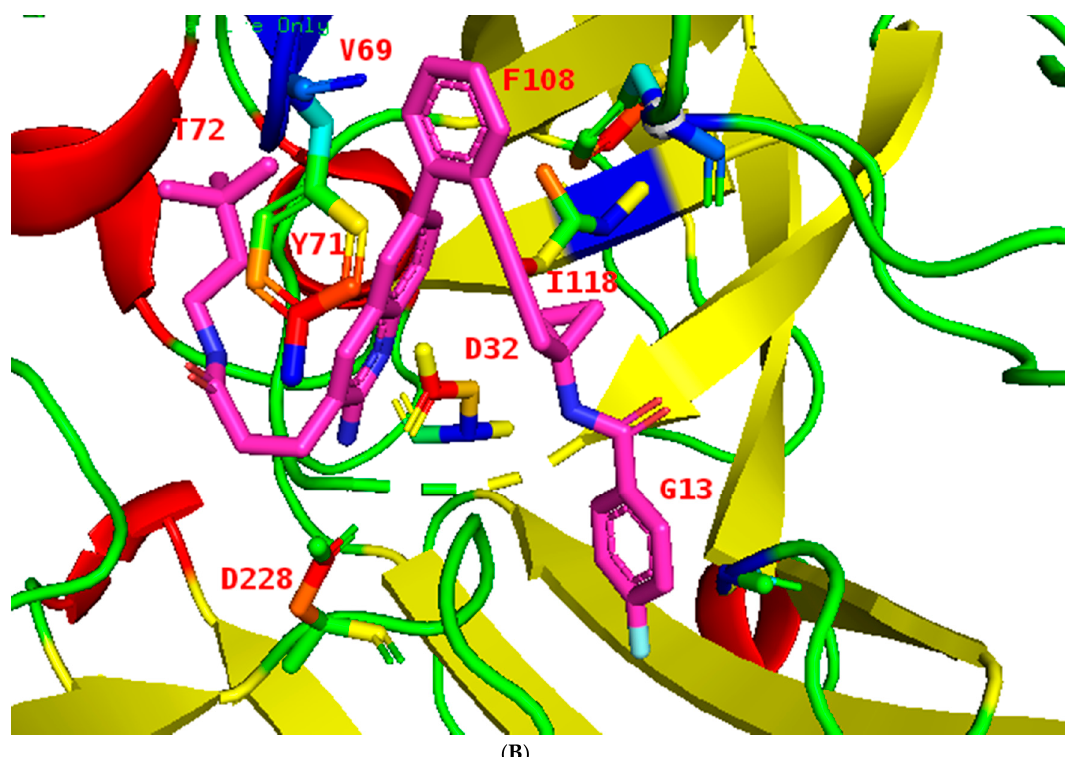
Figure 6. ( A ): Structures of BACE1 complexed with 1 (shown in cyan), showing the distances of the residues from inhibitor 1 in 5i3X, the aspartate pocket (Asp32 and Asp228), and the flap shown in orange which contains Val69 and Tyr 71. Distances are listed in Table 3 (for views of inhibitors binding to BACE1 see Figures S1–S8). Colors: helices light blue cylinders; flap orange brown; coils light pink. ( B ): The binding pocket of BACE1; inhibitor 1 in 5i3X is shown (pink) and all potential binding residues labeled, the flap shown in blue. Structure of BACE1 complexed with inhibitor 1 (shown in pink), interactions between ligand and protein at the catalytic aspartic acids Asp32 and Asp228 and at Trp72 of the S2’ region (Table 3). Colors: ß sheets Yellow; coils green; flap blue; helices red; Nitrogen atoms blue; inhibitor cyan. Table 3. Bond distances measured in the average structure using pymol.